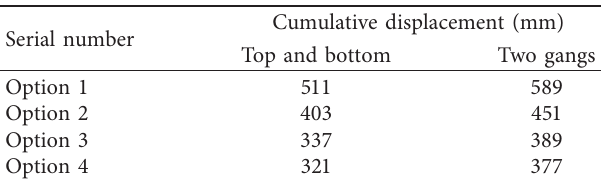
Figure 4: Plastic zone distribution of the surrounding rock. (a) Option 1. (b) Option 2. (c) Option 3. (d) Option 4. Table 6: The displacement curve about transportation roadway surface in different advanced support